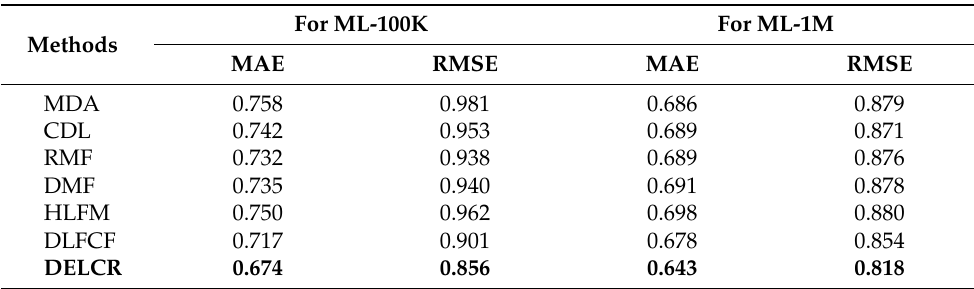
Table 3. Performance comparison result of DELCR for both datasets. The bold result is obtained using the proposed